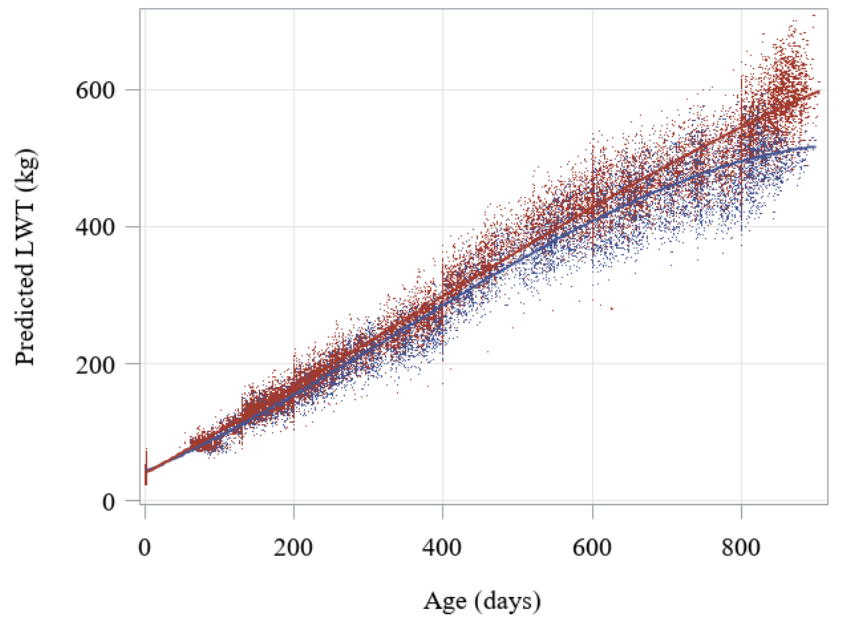
Figure 1. Predicted live weight (LWT, in kilograms) across age for beef-cross-dairy cattle ( n = 1101 with a total of 33,111 predicted weights calculated with centred moving average of 3 values), according to sex (▪ heifers in blue, ▪ steers in red).